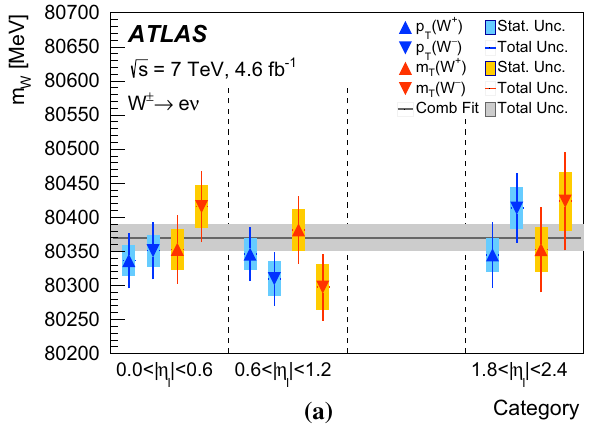
Fig. 23 Overview of the m W measurements in the a electron and b muon decay channels. Results are shown for the p (cid:7) butions, for W + and W − events in the different | η (cid:7) | categories. The